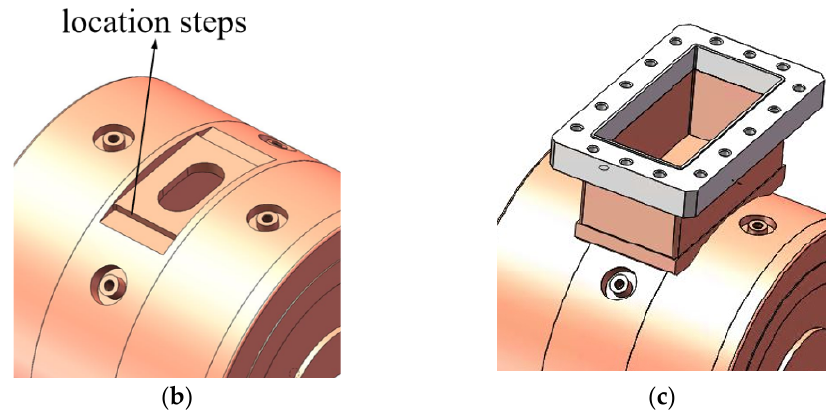
Figure 8. Schematic of the waveguide brazing with the middle cell. ( a ) Transition plate; ( b ) Main part of cavity; ( c ) After